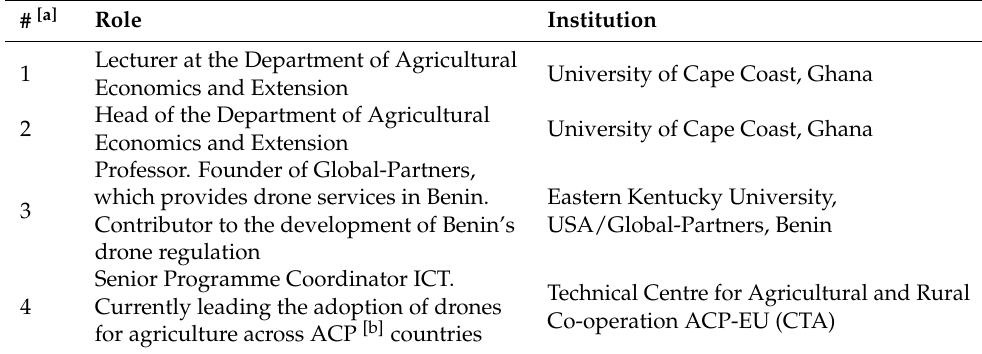
Table 6. Profile of